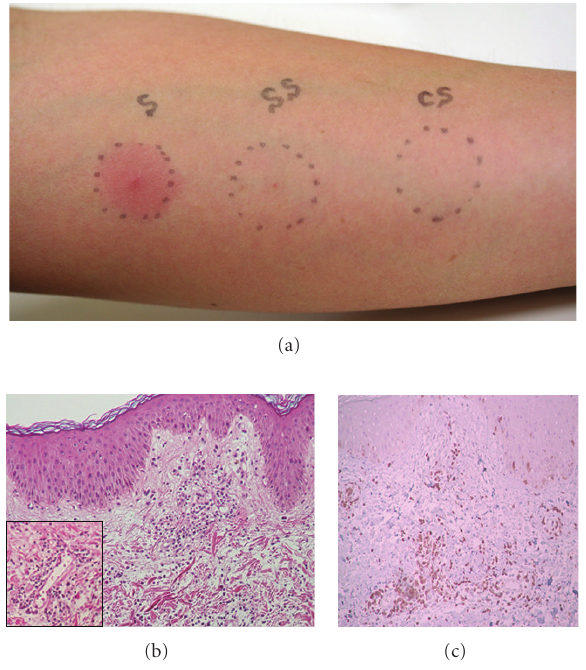
Figure 2: (a) 33-year-old female ABD patient showed erythema reaction exhibiting more than 10mm in diameter by self-saliva (salivary prick: S-prick) 48 hours after prick. A tinny spot by sterilized self-saliva (sterilized salivary prick: SS-prick) and control saline (control saline prick: CS-prick) were observed. (b) Histology of the skin reaction by S-prick from 27-year-old male ABD patient. Edema in the upper dermis and many mononuculear cell infiltration around the dilated vessels in the middle dermis were found (HE, 100x). The magnified view of the vascular change with infiltrate (200x). (c) Immunochemical histology of the skin reaction by S-prick. (avidin-biotin complex peroxydase method: ABC method, 200x). Infiltration of CD3+/CD4+ cells is mainly found around vessels and the proportion of infiltrate was CD3+/4+ > CD68+ > CD8+ cells. No CD20+ and CD56+ cells were found.